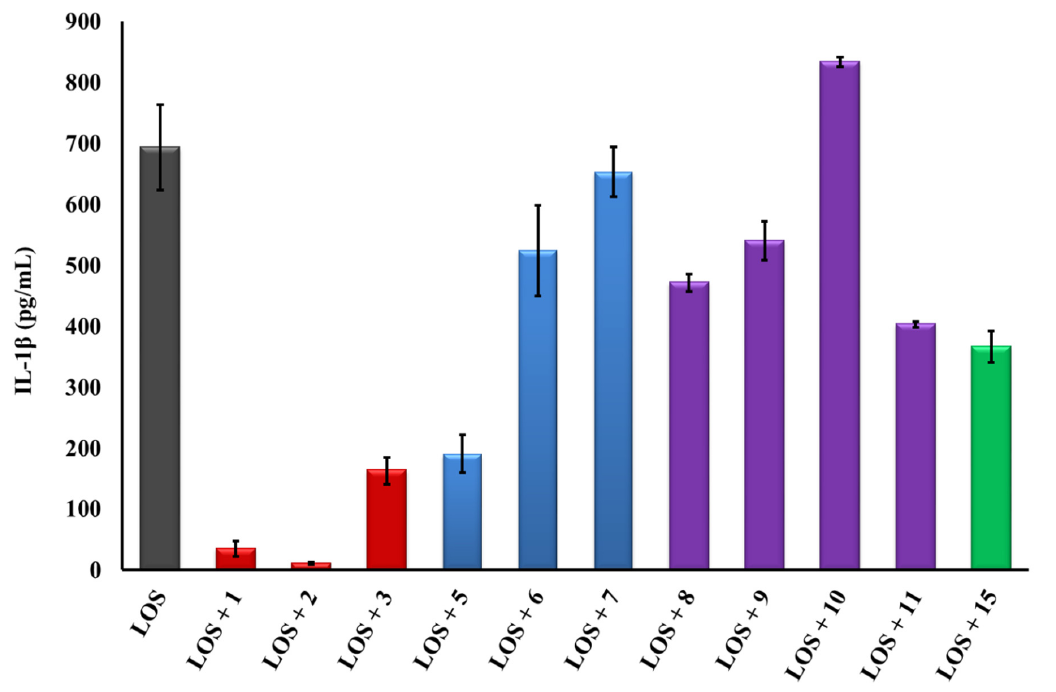
Figure 4. PG-1 analogs neutralized meningococcal LOS activity and inhibited IL-1 β release. IL-1 β was released from human macrophage-like THP-1 cells induced overnight with meningococcal LOS (5 ng/mL ~ 2.5 pmole/mL) preincubated with or without 2 µg/mL of PG-1 or its derivatives for 30 min at 37 °C. IL-1 β release was measured by ELISA. Error bars represent ±SD from the mean of duplicate measurements. This experiment is representative of two independent experiments. Methylated: N-methylated tyrosine or phenylalanine derivatives; S-S: disulfide